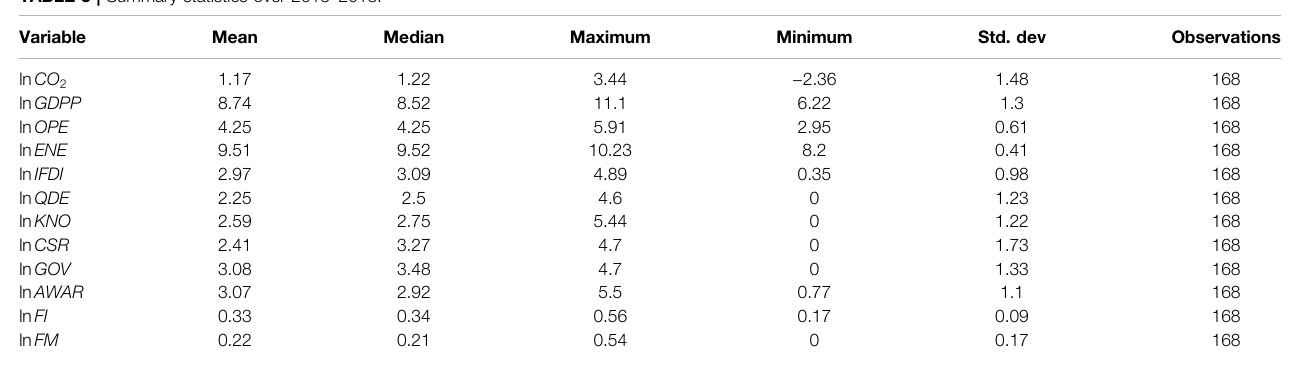
TABLE 3 | Summary statistics over 2013 –